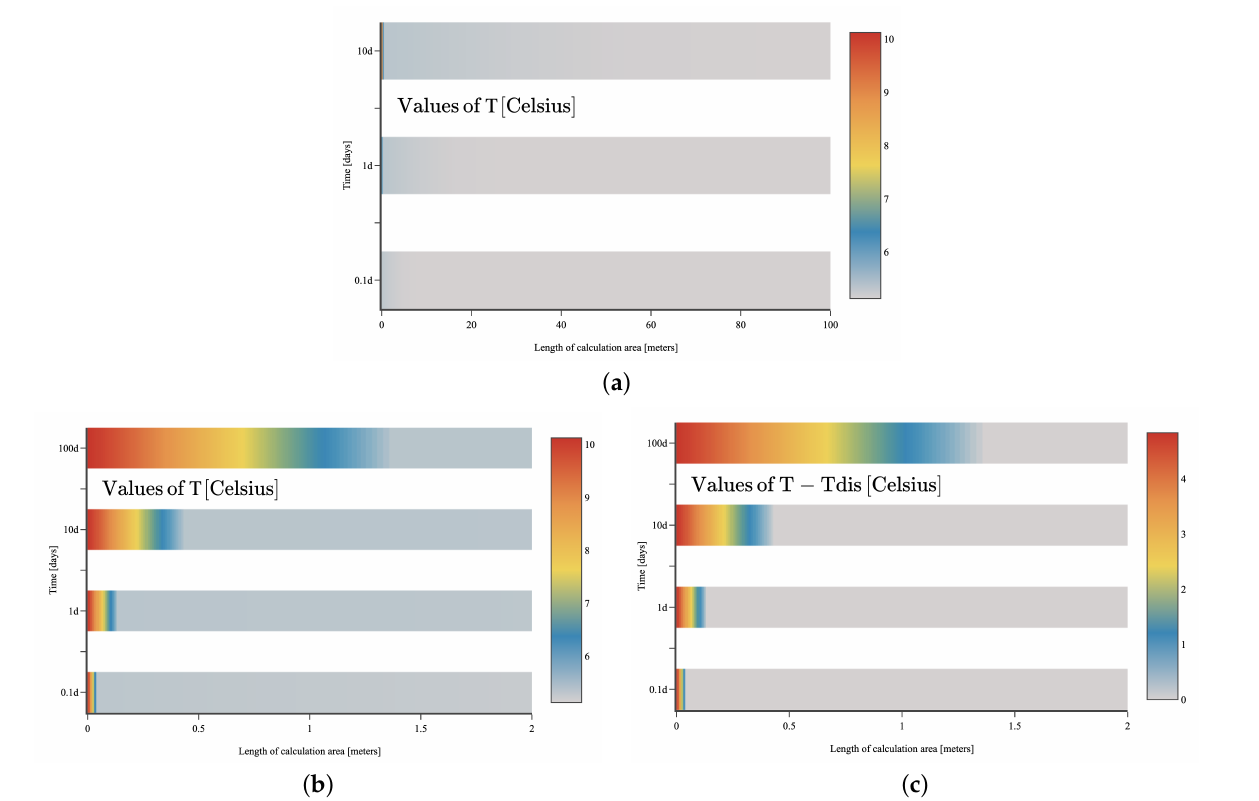
Figure 4. ( a ) Temperature profile T for time moments t = 0.1, 1, 10 days. X-axis: calculation length in horizontal direction of the reservoir is taken long way from the fault (up to 100 m), where 0 X-value represents the fault. ( b ) Temperature profile T in the nearest area around the fault for time moments t = 0.1, 1, 10, 100 days. X-axis: calculation length in horizontal direction of the reservoir is taken close to the fault (up to 2 m), where 0 X-value represents the fault. ( c ) Temperature increasing profile T − T dis ( P ) ( T dis ( P ) is the temperature of the dissociation that is a function of pressure instantaneous value) in the area around the fault for time moments t = 0.1, 1, 10, 100 days. X-axis: calculation length in horizontal direction of the reservoir is taken close to the fault (up to 2 m), where 0 X-value represents the fault.